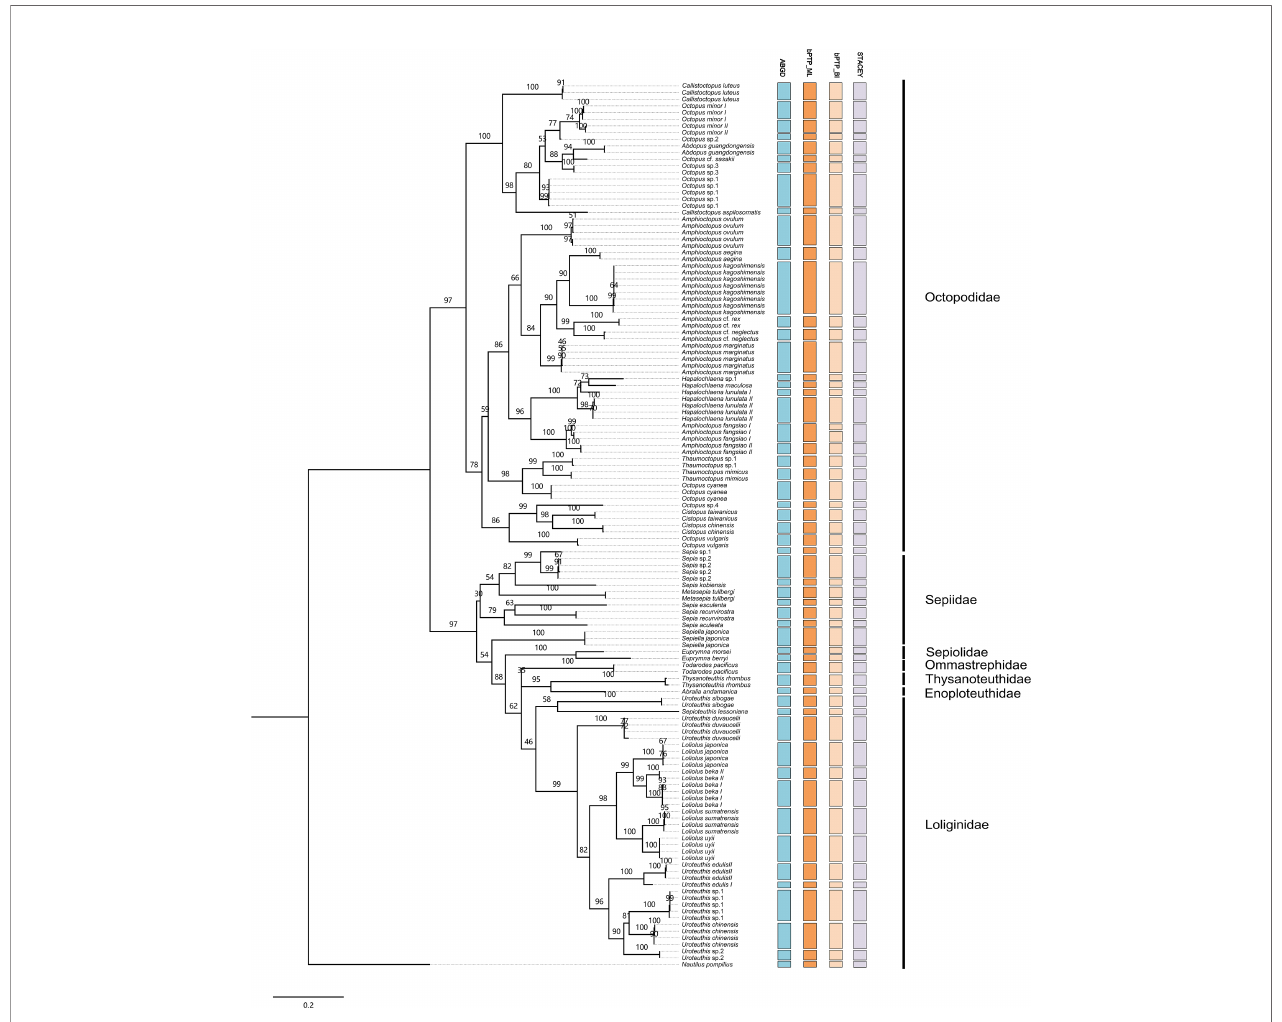
FIGURE 2 | Summary of species delimitation results via Species Tree and Classi fi cation Estimation Yarely, automatic barcode gap discovery, and Bayesian Poisson tree processes model. The phylogenetic structure was induced by the Maximum Likelihood tree. Each column with a different color represents a species detected by molecular delimitation. The number in each node represents the bootstrap